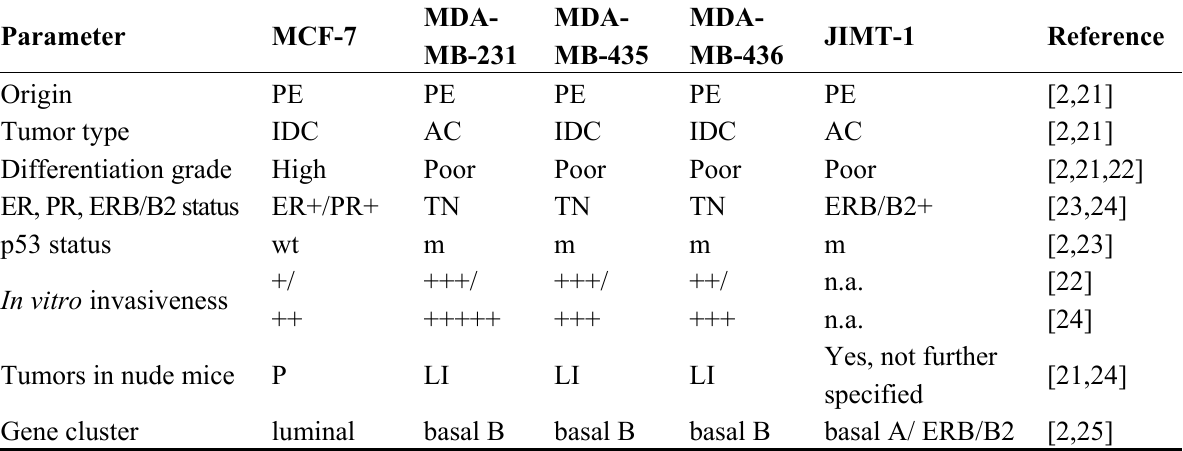
Table 1. Characterization of breast cancer cell lines for their histological characteristics, cancer specific gene expressions, and tumor